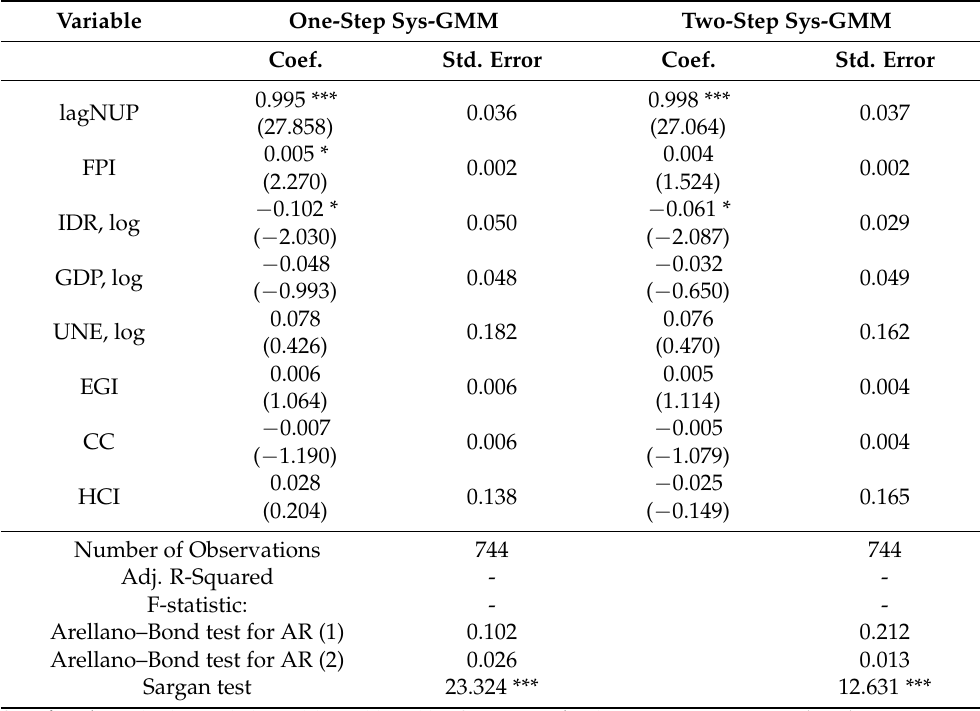
Table 3. Regression results of one and two-step sys-GMM estimations for African countries. Variable